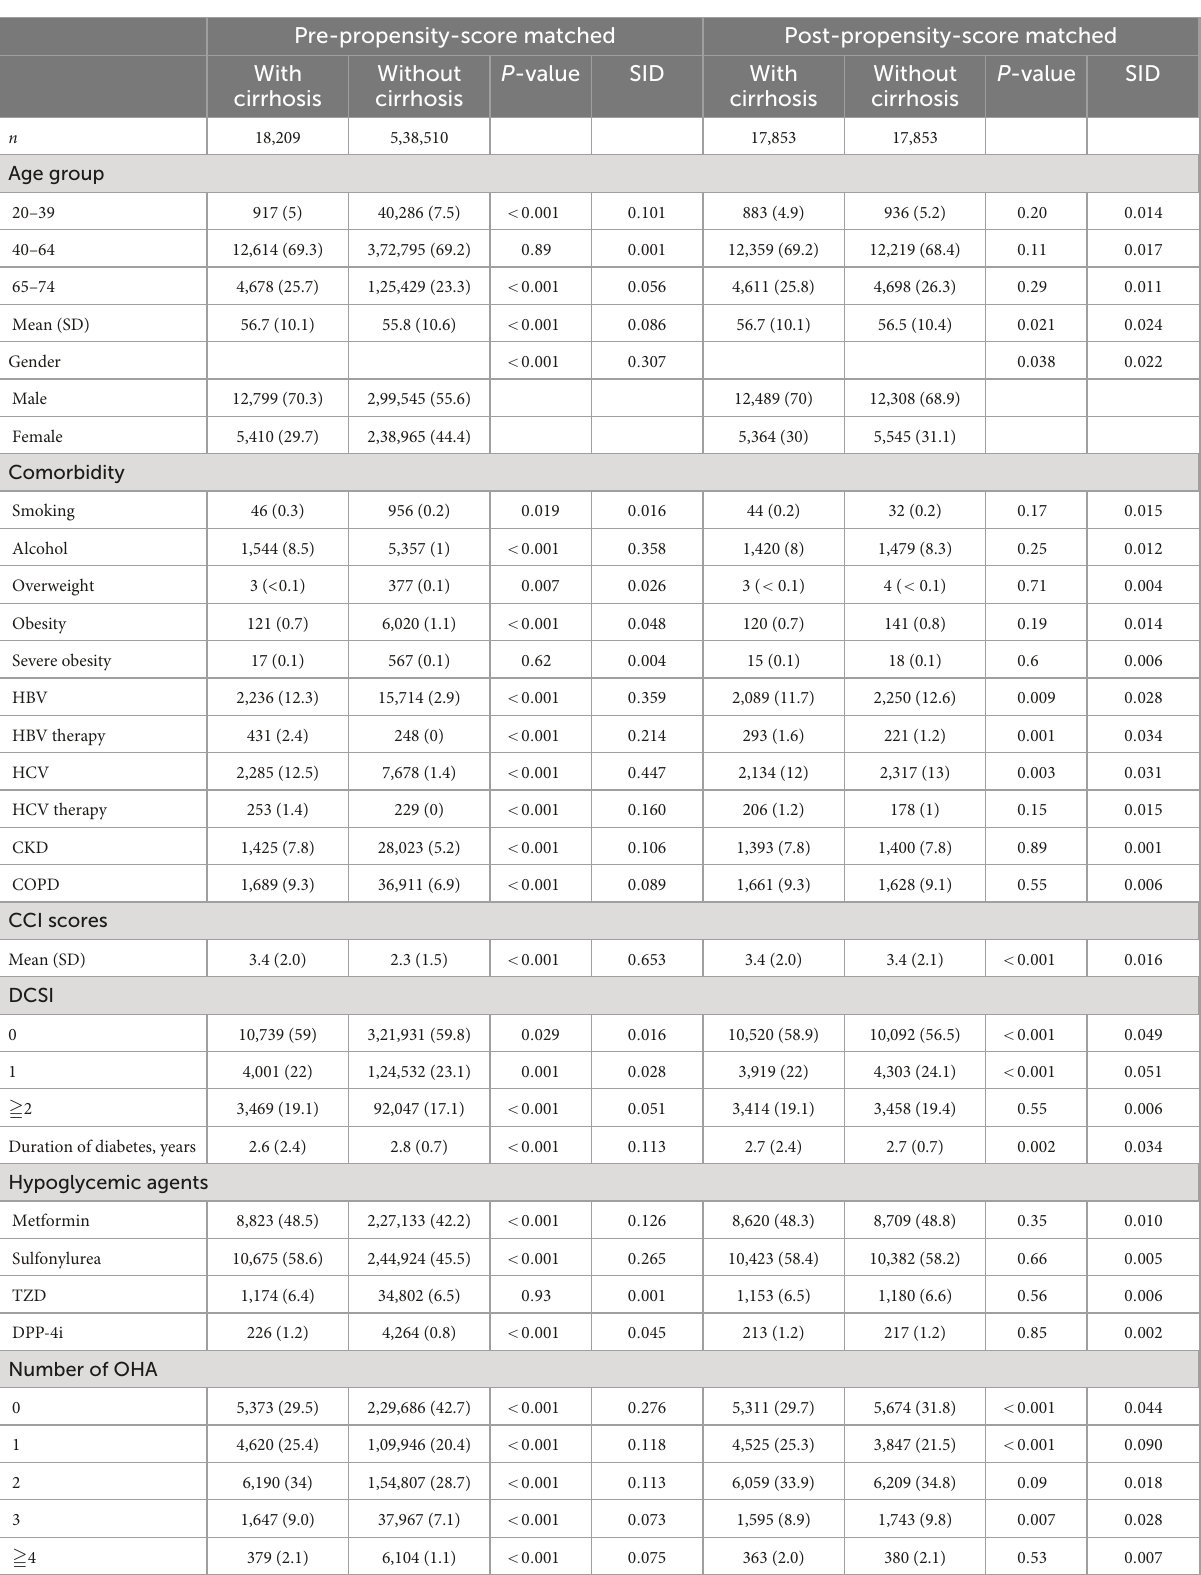
TABLE 1 Basic characteristics of pre-matched and post-matched data in patients with type 2 diabetes with and without liver cirrhosis. Pre-propensity-score matched Post-propensity-score